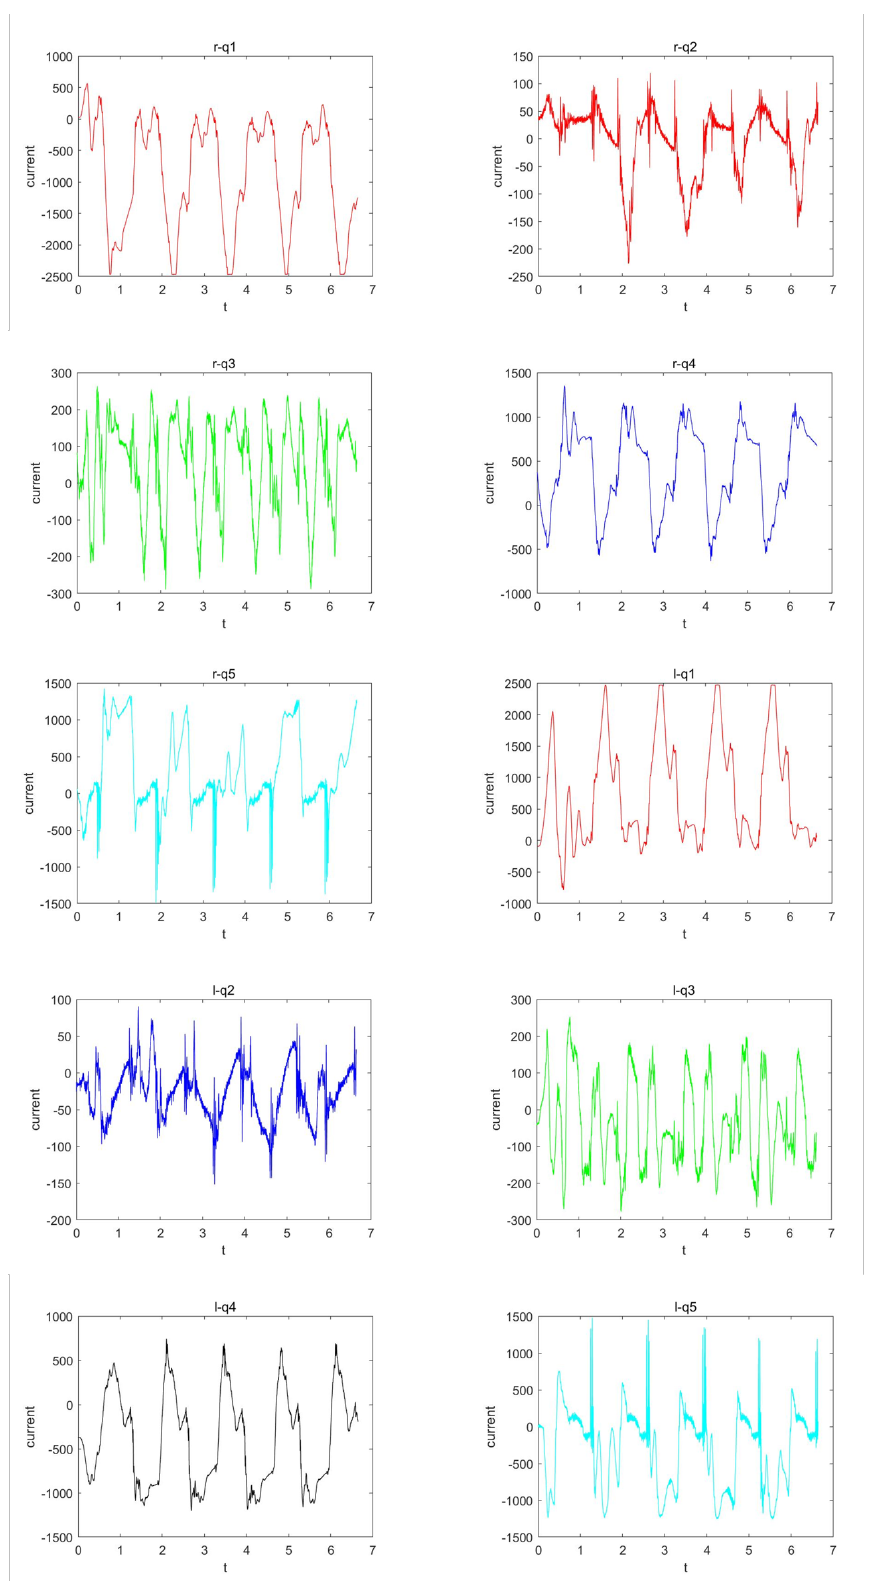
Figure 13. Experiment data. When the robot steps at the speed of 3 mm/ms on the ground, the current data collected by the driver. Some motors exceed the rated current during movement, and even greatly exceed the rated current for a long time. Among them, the motor q 1 once exceeds more than twice the rated current during